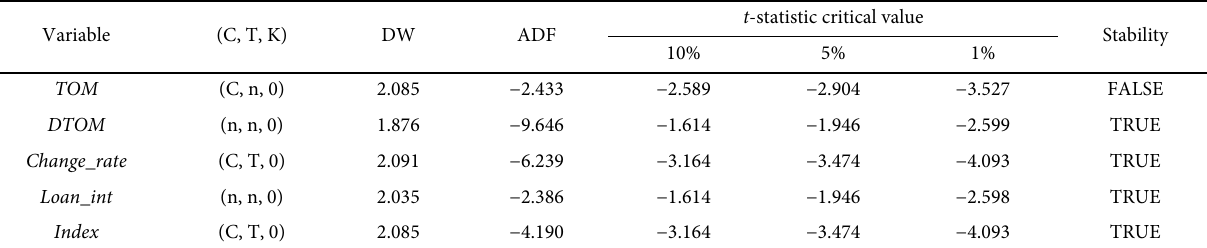
Figure 3b is the time-point impulse responses of the housing market liquidity ( DTOM ) to the credit scale ( Chang_rate ). The dotted and dashed lines respectively represent the time points in 2014 and 2015 when the market was downward and the credit policy was loose. The solid and dotted-dashed lines respectively represent the time points in 2016 and 2017 when the market was upward and the credit policy was tightened. First, when the credit volume expands by one standard deviation, TOM rises and the Table 2 Results of ADF tests for all time series variables.